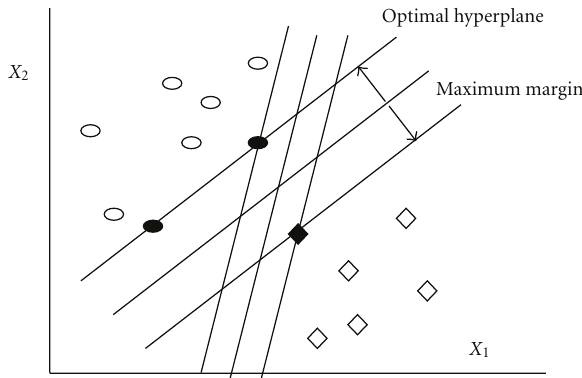
Figure 1: Maximum margin of optimal